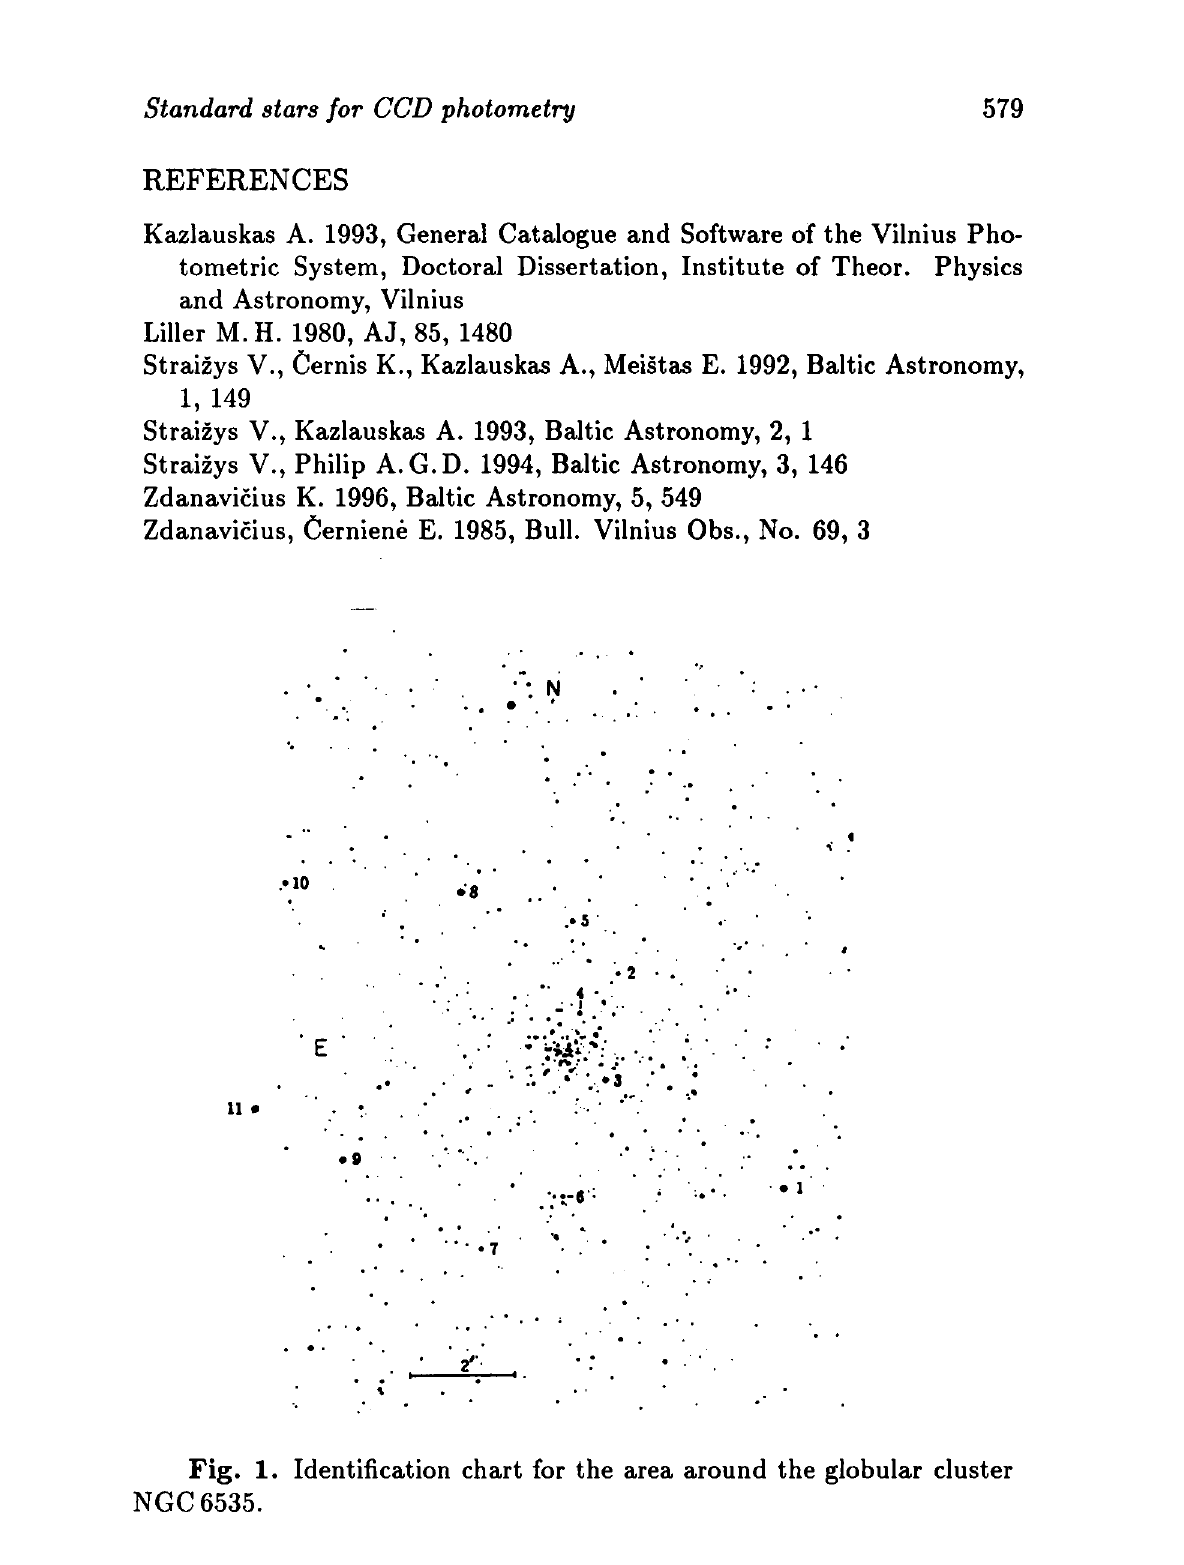
Fig. 1. Identification chart for the area around the globular cluster